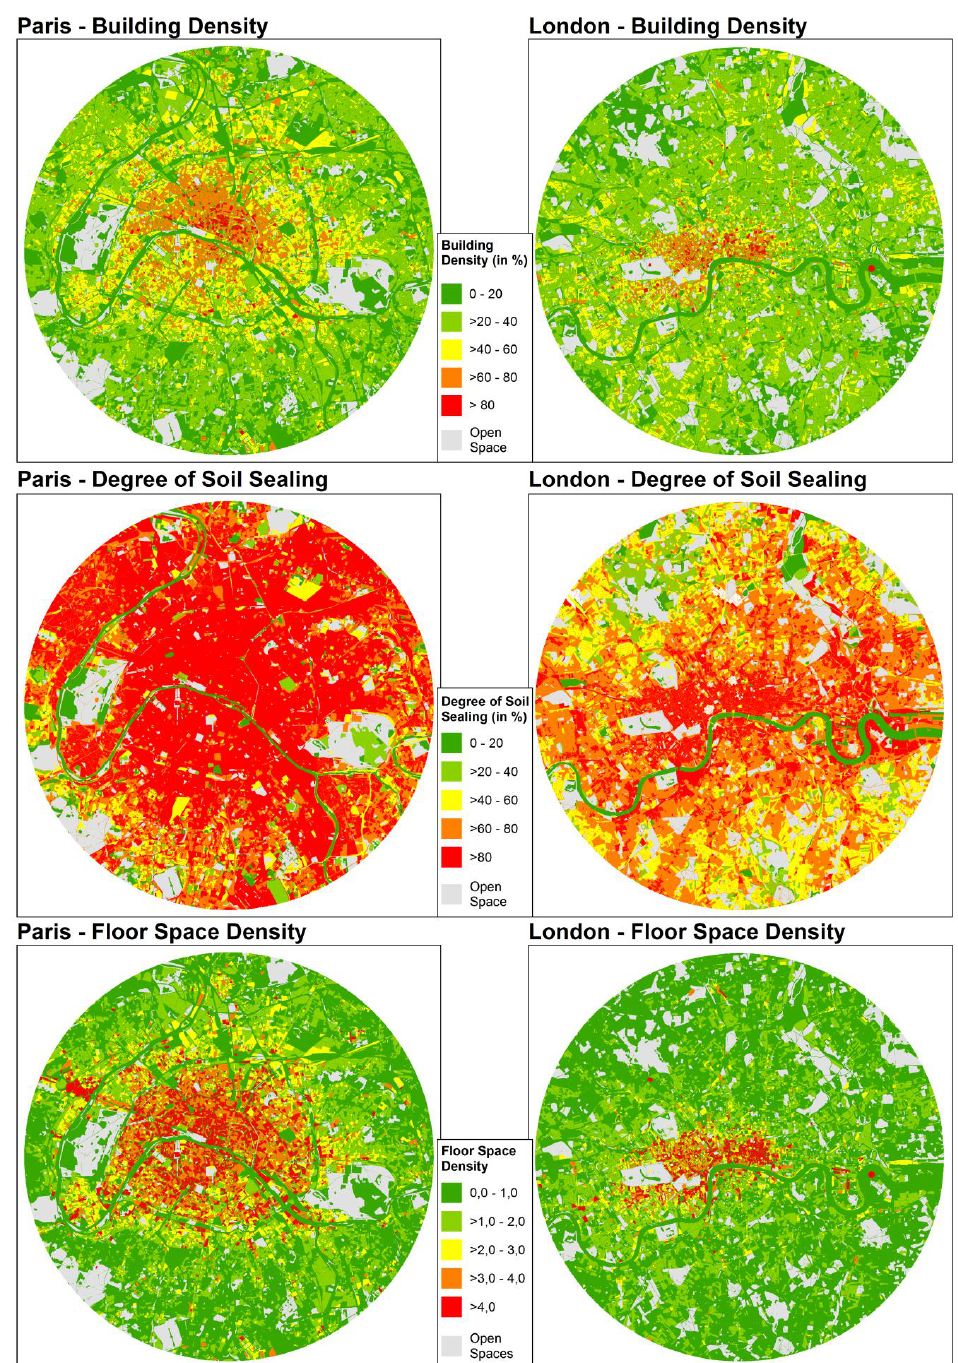
Figure 4. Density maps at block level for Paris and London: ( a ) Building density; ( b ) Soil Sealing; and ( c ) Floor Space Density.